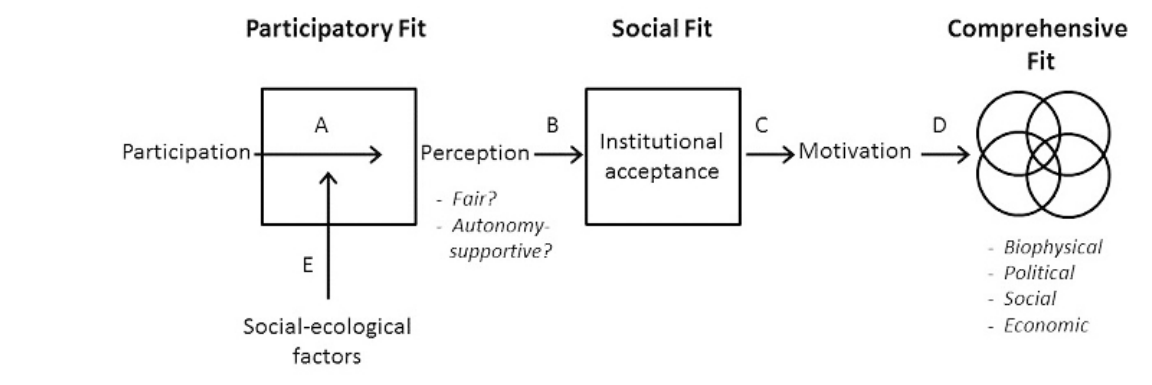
Fig. 1 . Behavioral process model linking participatory fit, social fit, and comprehensive